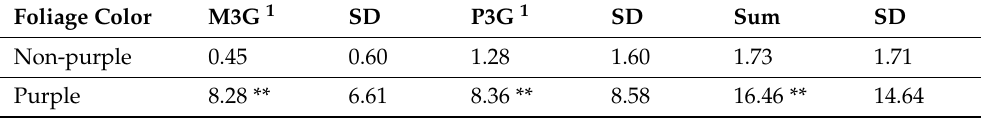
Table 4. Concentration of peonidin-3-glucoside, malvidin-3-glucoside, and total anthocyanin in petiole tissue of Eastern redbud ( Cercis canadensis L.) for plants with different foliage colors. Foliage